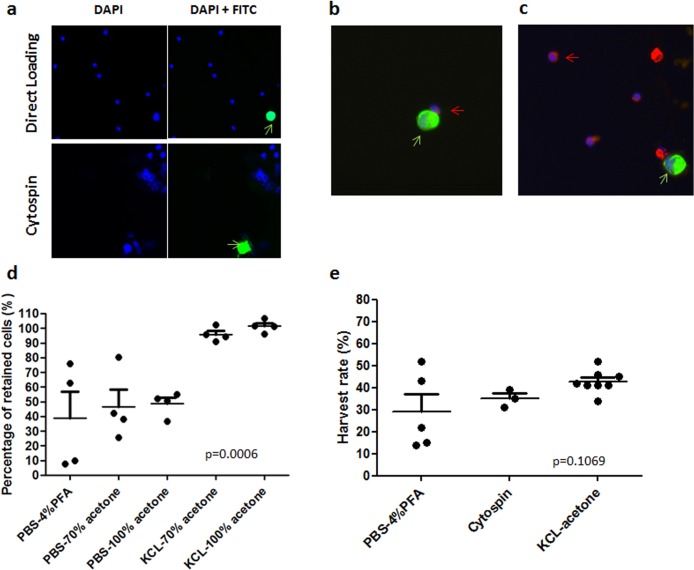
Optimization of cell transfer and fixation for immunofluorescence analysis using spiked samples.(A) Representative images to show a CellTracker Green pre-labeled PC3 cell with damaged morphology (green arrow) after Cytospin (lower panel), compared with a round pre-labeled PC3 cell (green arrow) in direct cell loading method (upper panel). (B) and (C) Using both (B) PBS-4% paraformaldehyde and (C) KCl-acetone cell transfer and fixation methods, CK expression (green signals) on PC3 cells (green arrows) and CD45 expression (red signals) on lymphocytes (red arrows) were clearly detected with strong and specific fluorescence signals. (D) Percentage of cells retained after immunofluorescence staining process for cells with different re-suspension solutions and fixations. Both 70% and pure acetone fixation in combination with KCl re-suspension of cells achieved a retention rate of more than 90%. (E) Harvest rates of spiked PC3 cells using different cell transfer and fixation methods. KCl-acetone had the highest rate, Cytospin had a lower but more stable rate and PBS-4% paraformaldehyde had the lowest and most unstable rate.